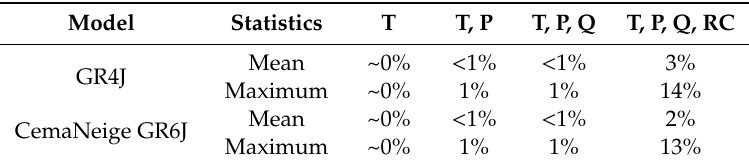
Figure 8. Rating curve (yellow line) for the Blejski most station on the Sava Dolinka river with periodical discharge and water level measurements (points). Table 3. Overview of the measurements and rating curve errors on the rainfall-runoff modelling results using GR4J and CemaNeige GR6J models. The difference between the minimum and maximum simulated discharge values of the 100 model runs, calculated for all mean and maximum simulated discharge values, is shown.